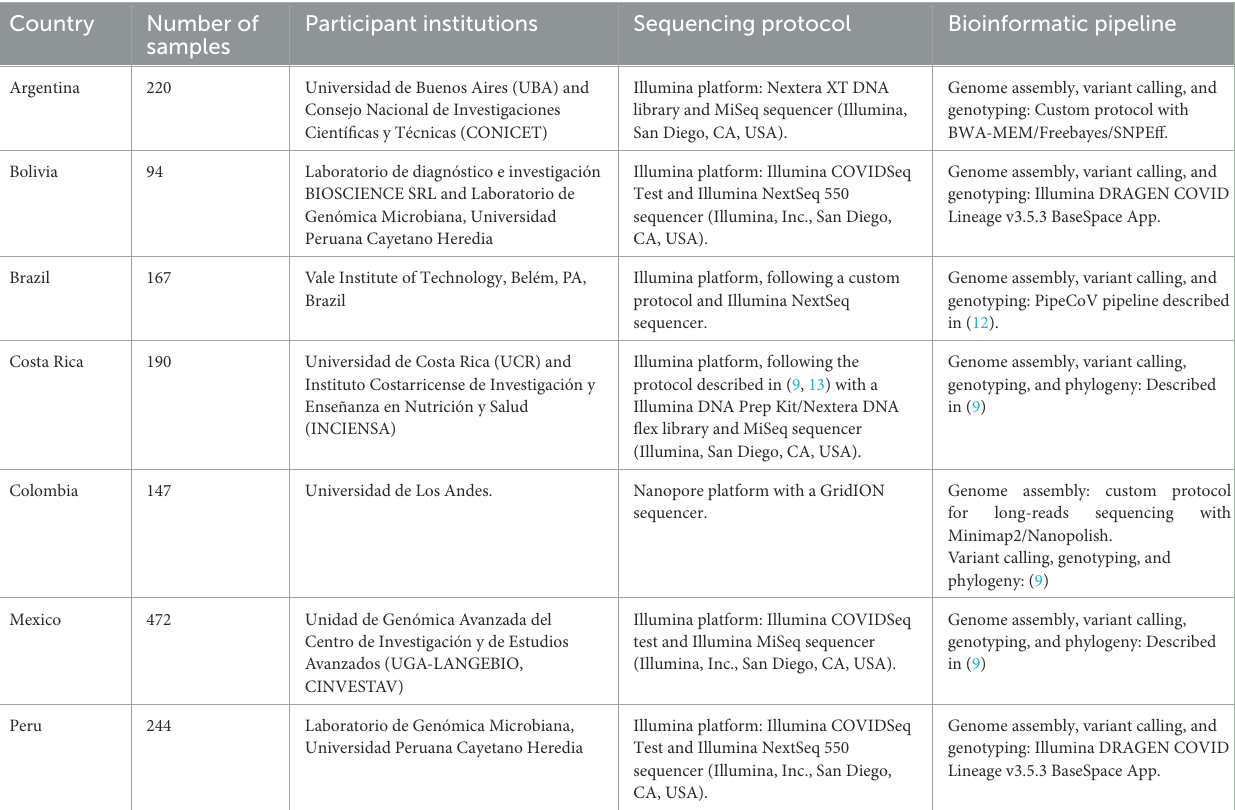
TABLE 1 Sequencing strategy and bioinformatic pipelines used for the genomic surveillance of the SARS-CoV-2 in five Latin American countries, CABANA initiative. Country Number of